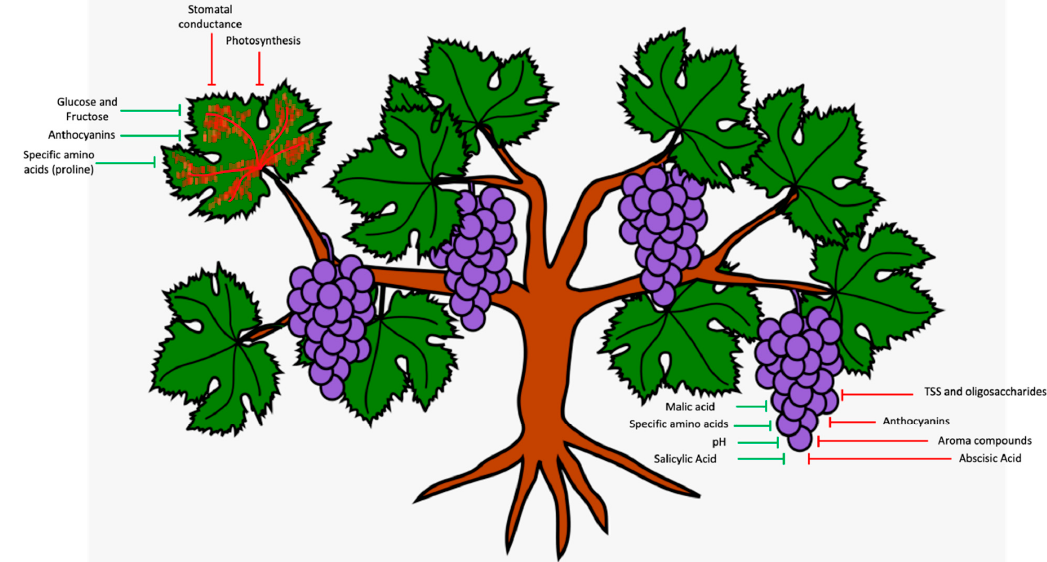
Figure 3. The overall impact of grapevine red blotch virus (GRBV) on grapevine physiology and grape metabolism. Green indicates an increase and red indicates a decrease in concentration. TSS = total soluble solids.